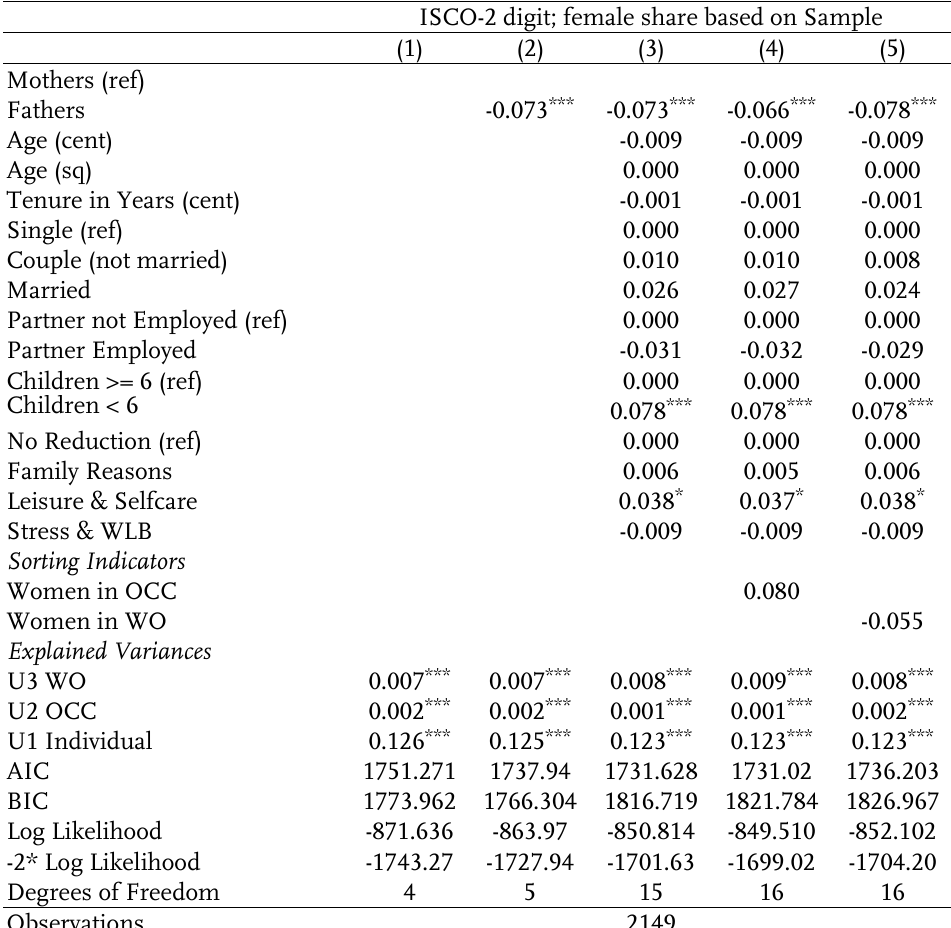
Sensitivity analyses: Gender differences full-time men & women with different